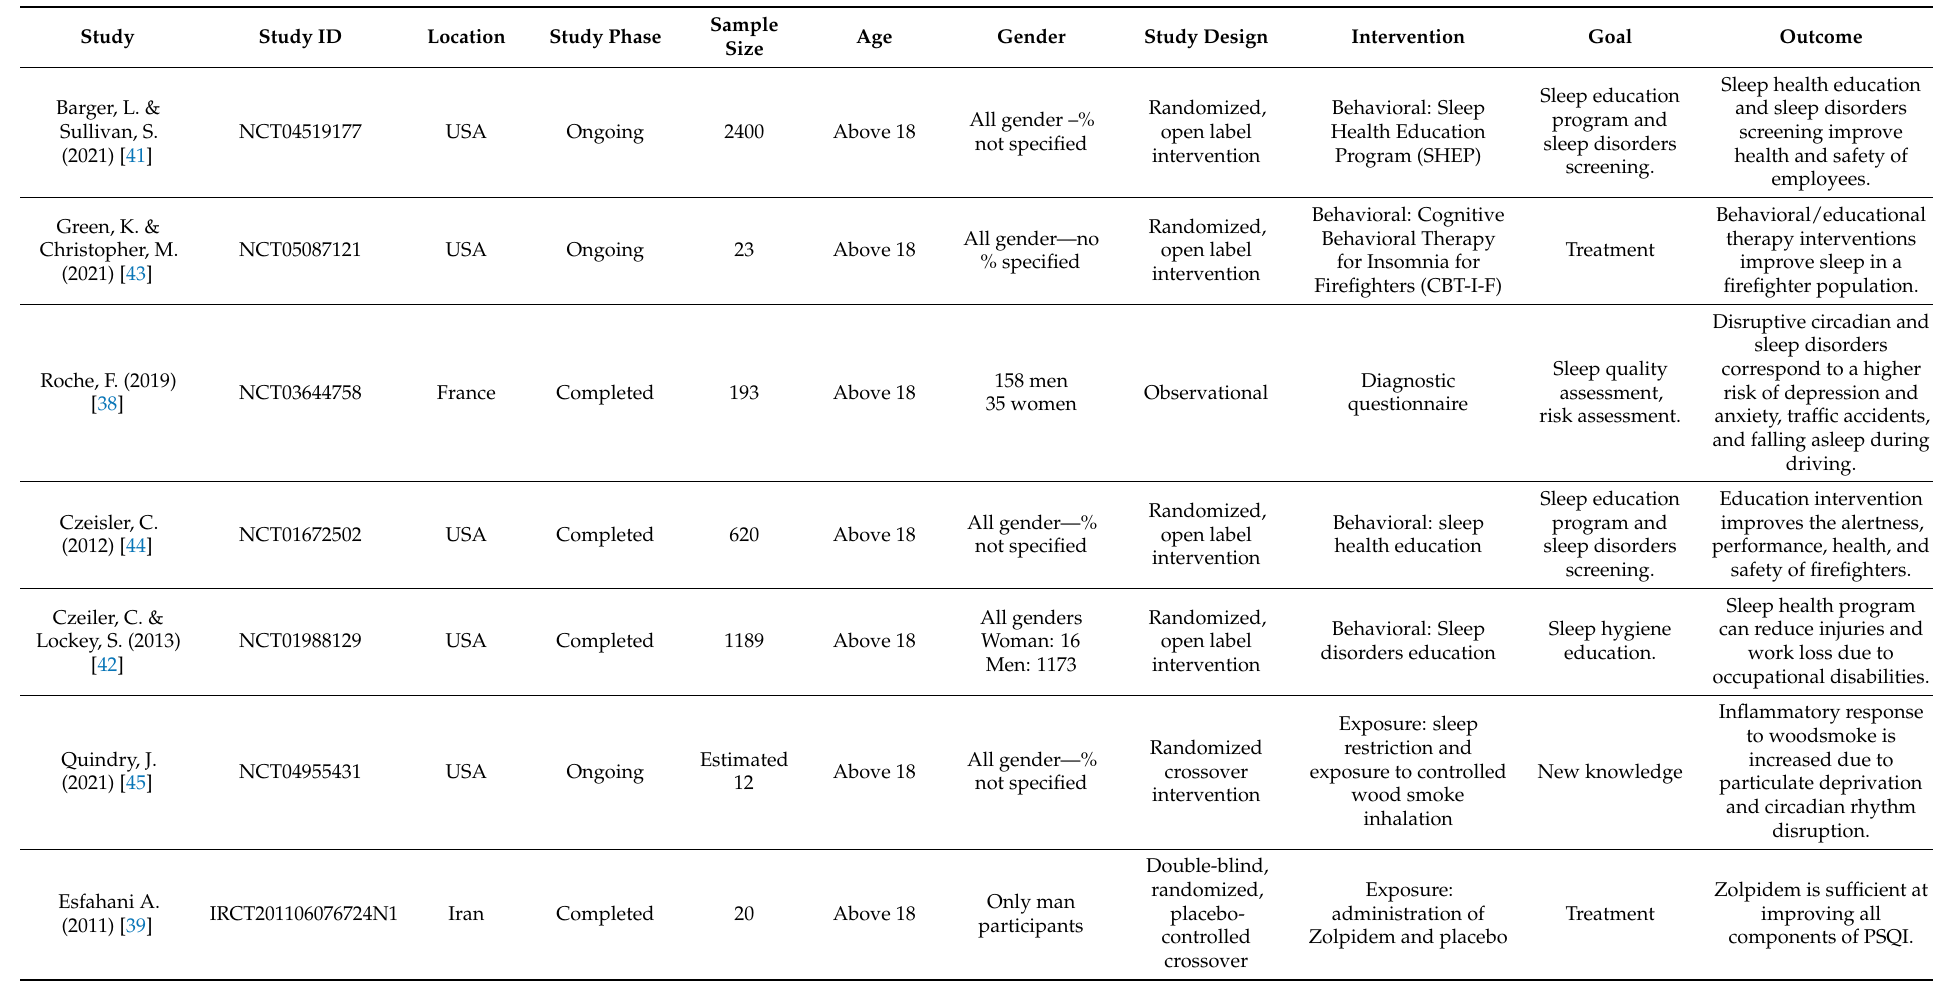
Table 4. General description of included